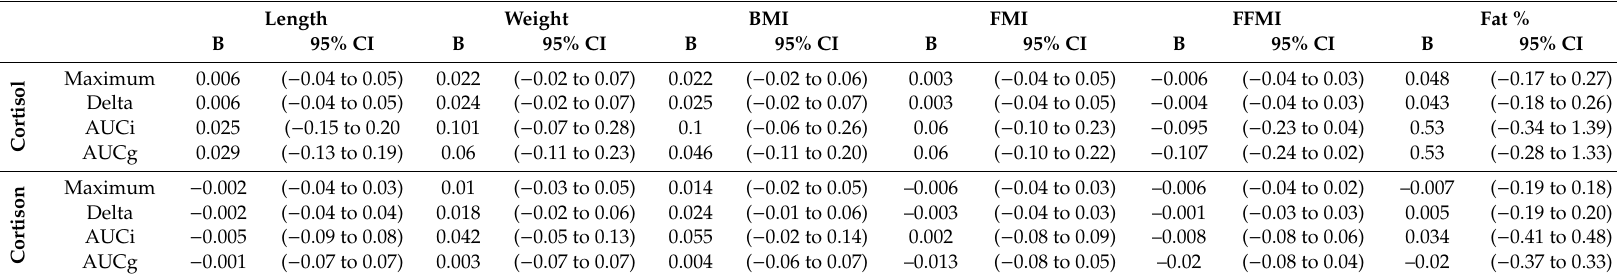
Table 2. Adjusted associations between breastmilk glucocorticoid rhythmicity at 1 month of age and infant body composition at 3 months of age ( n =